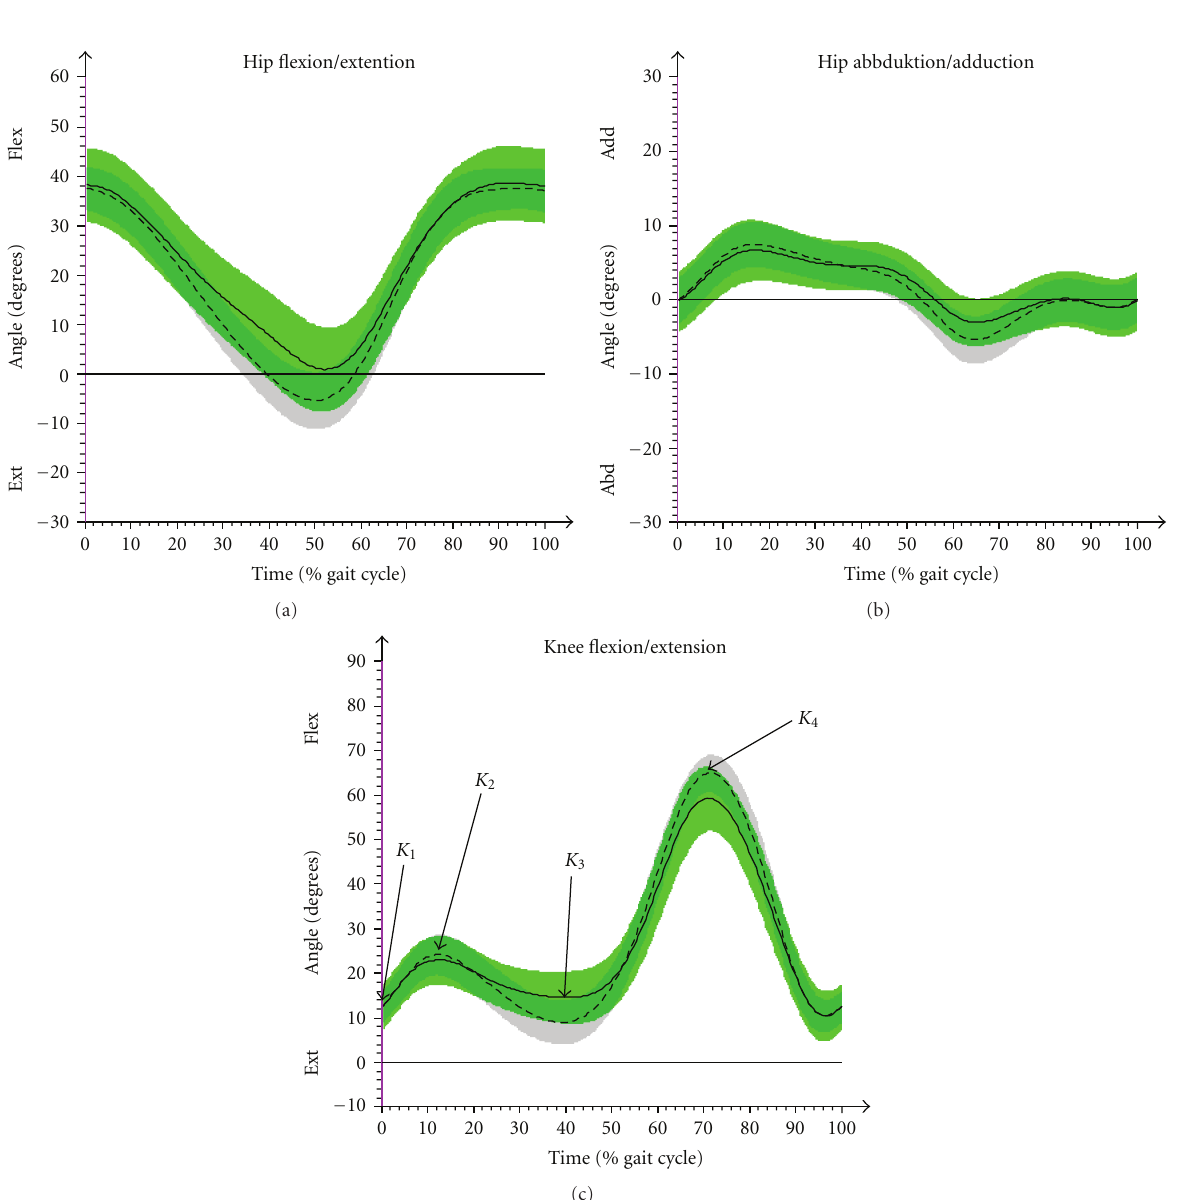
Figure 4: Results of gait analysis of CG (arithmetic mean & SD (---)) and JIA-P (arithmetic mean & SD (—)) in hip (a) flexion/extension, (b) abduction/adduction, and knee joint, (c) flexion/extension. K 1 (initial contact), K 2 (max. flex in loading response), K 3 (max. extension in single support phase), and K 4 (max. flexion in swing) are the points of interest in knee joint that were used for statistical analyses.